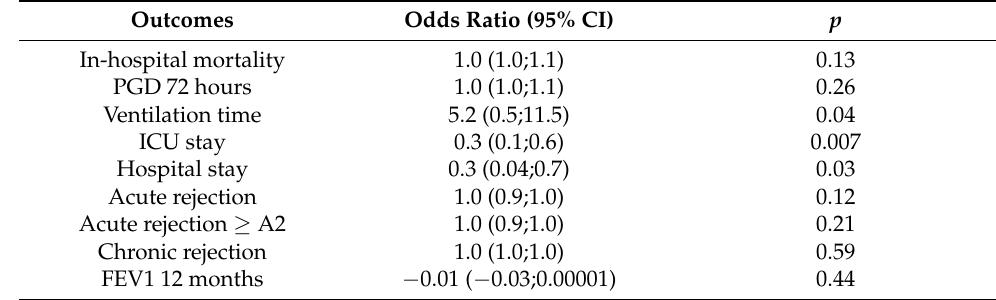
Table 5. Univariate analysis of smoking history association with postoperative outcomes. Donor smoking history is considered a continuous variable.